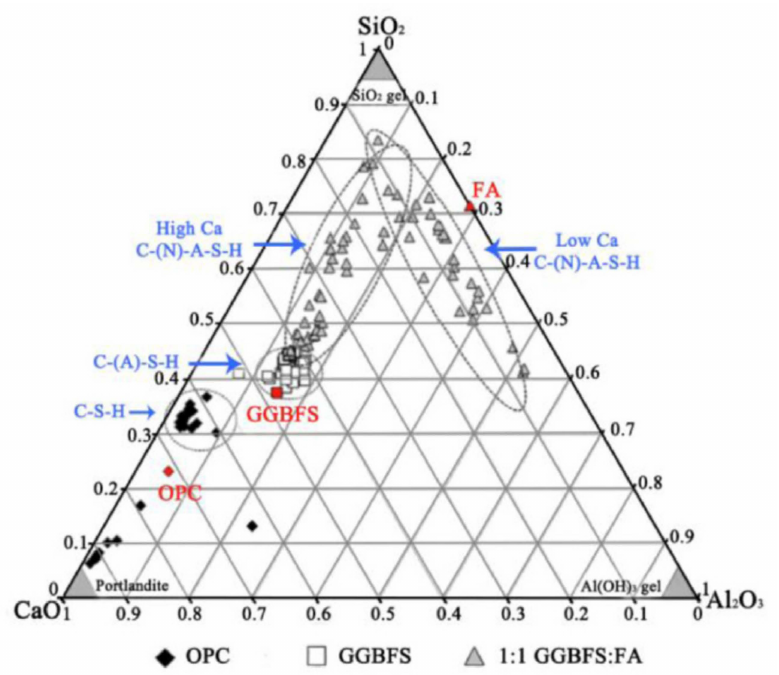
Figure 2. OPC and GPC composition of binder gel; reprinted with permission from